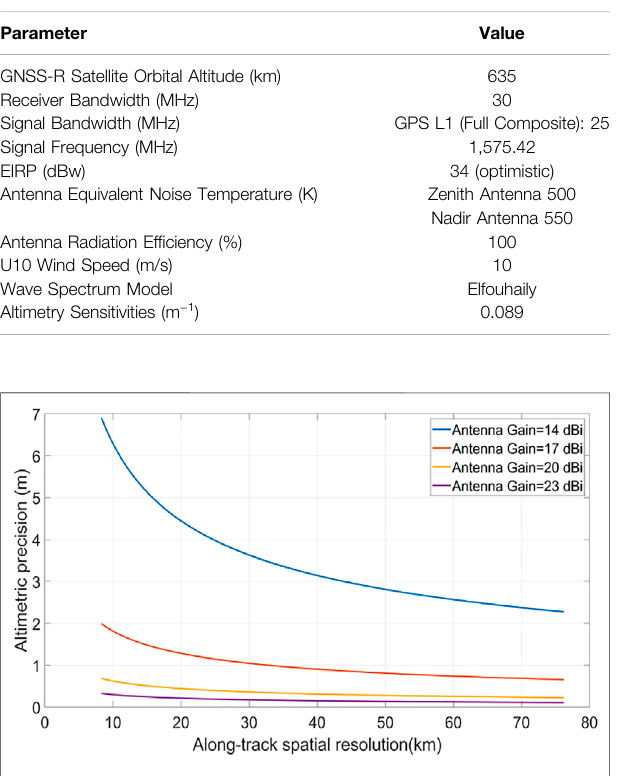
FIGURE 9 | Relationship between precision and spatial resolution under different antenna gains at elevation angle of 75 degrees in the spaceborne scene.